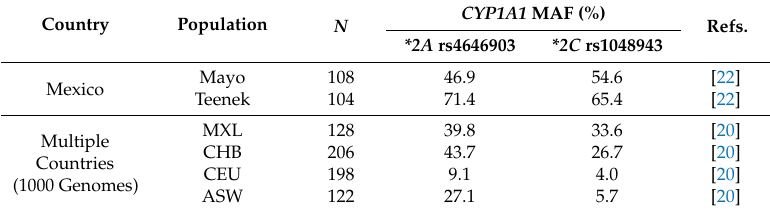
Table 2. Comparison of CYP1A1 allele frequencies in Indigenous North American populations to global populations from the 1000 Genomes Project [20]. N represents the number of alleles. Global populations are abbreviated as follows: African Ancestry in Southwest US (ASW); Utah residents with Northern and Western European ancestry (CEU); Han Chinese in Beijing, China (CHB); Mexican Ancestry in Los Angeles, California